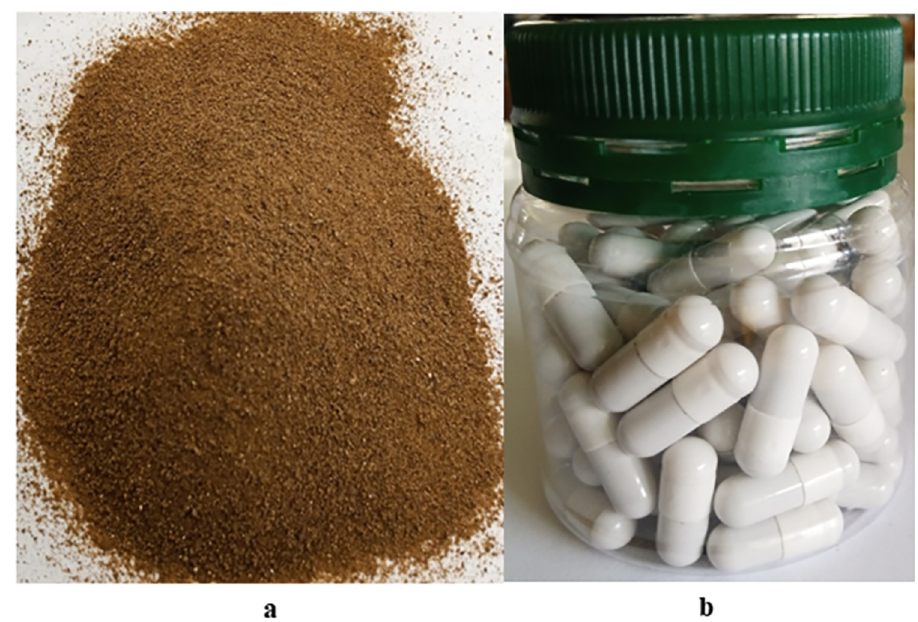
Fig 4. Herbal granules (A) and the DM083 capsules (B). ( a ) Herbal granules contain 76% of dried herbal extracts as active pharmaceutical ingredients mixed with excipients. ( b ) Herbal capsules in a plastic airtight container; were produced using a manual capsule filling machine [Lodha, LI-CFM 300, India]. The capsules have a size of 00 and contain 600 mg of herbal granules.